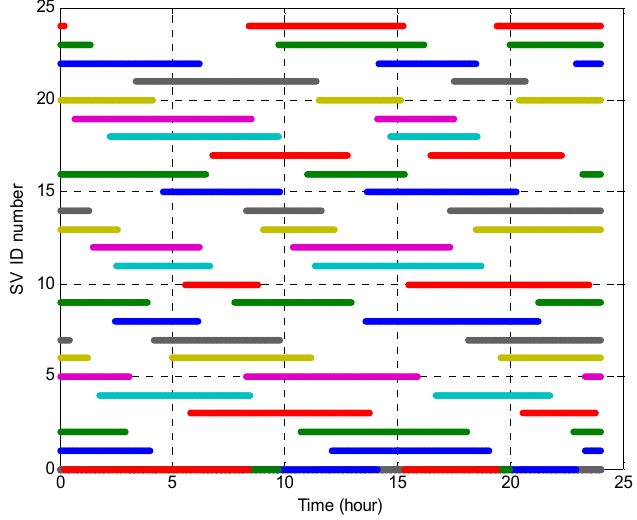
Figure 3. Exposed time of GPS satellites visible when the elevation mask is five degrees.